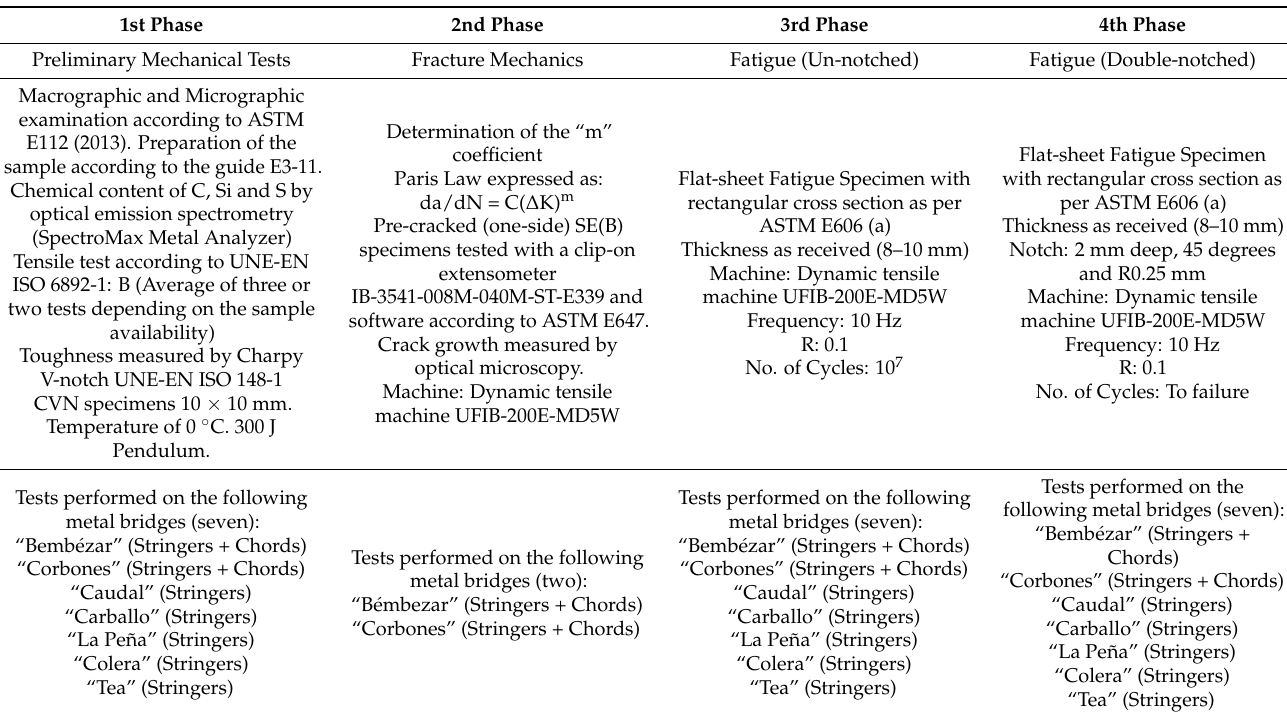
Table 2. Experimental design and testing